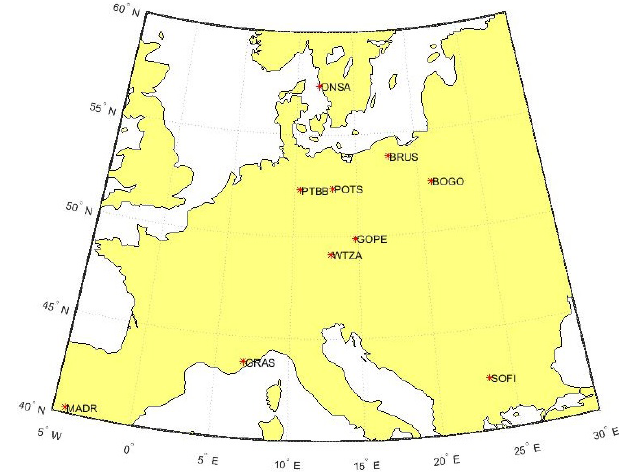
Figure 2. IGS station locations.